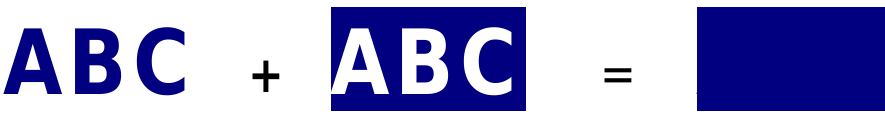
Figure 12. The print and the imprint [6b] are